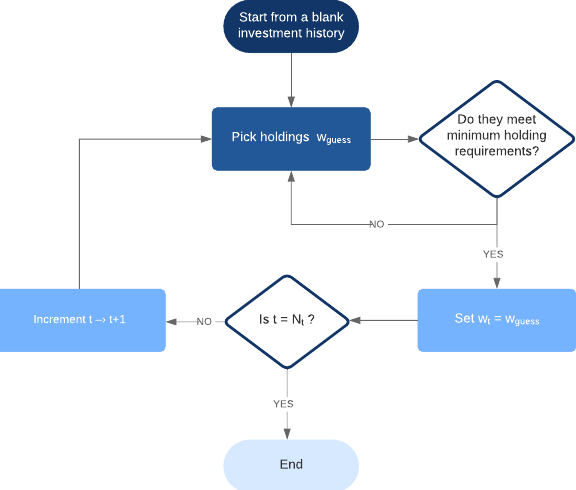
Figure 1. Flow chart detailing the post-selection algorithm used to efficiently eliminate trajectories which do not meet the minimum 7 day holding period.